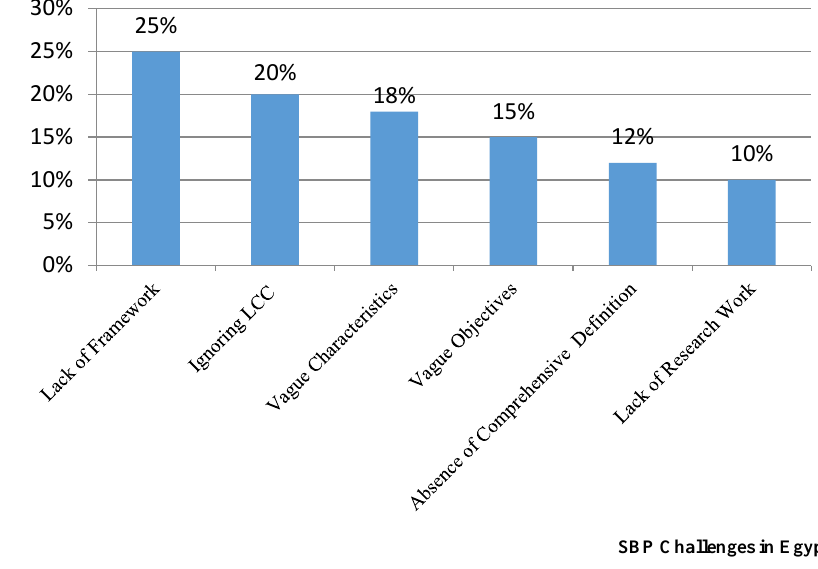
Figure 2. The Key Challenges of SBP in Egypt; Source: Authors Based on Literature Sources and Analysis of Case Studies